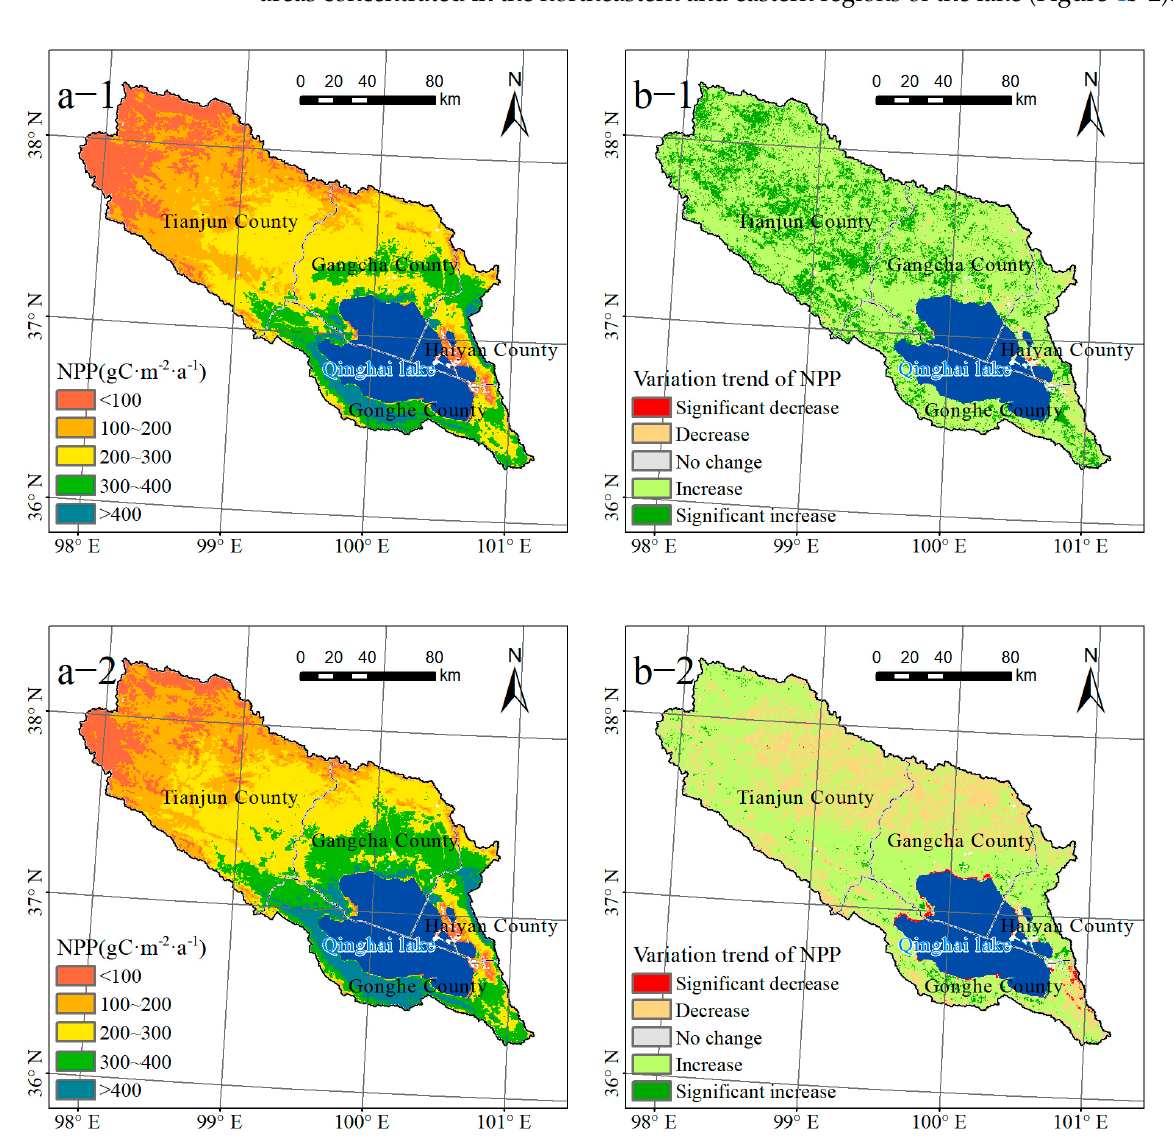
Figure 4. Spatial distribution ( a ) and change trend ( b ) of net primary productivity (NPP) in Qinghai Lake Basin from 2001 to 2020 (1 and 2 are 2001–2010 and 2010–2020, respectively).